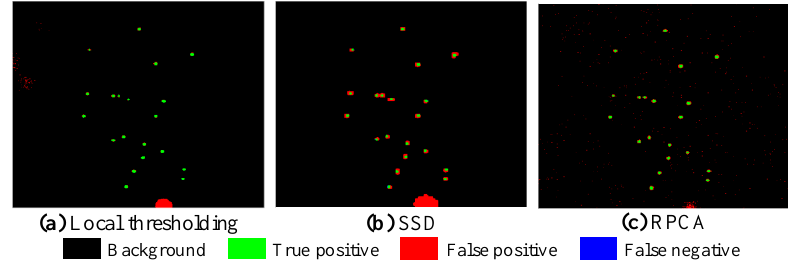
Figure 7. The extracted sparse component based on local thresholding, SSD, and RPCA.